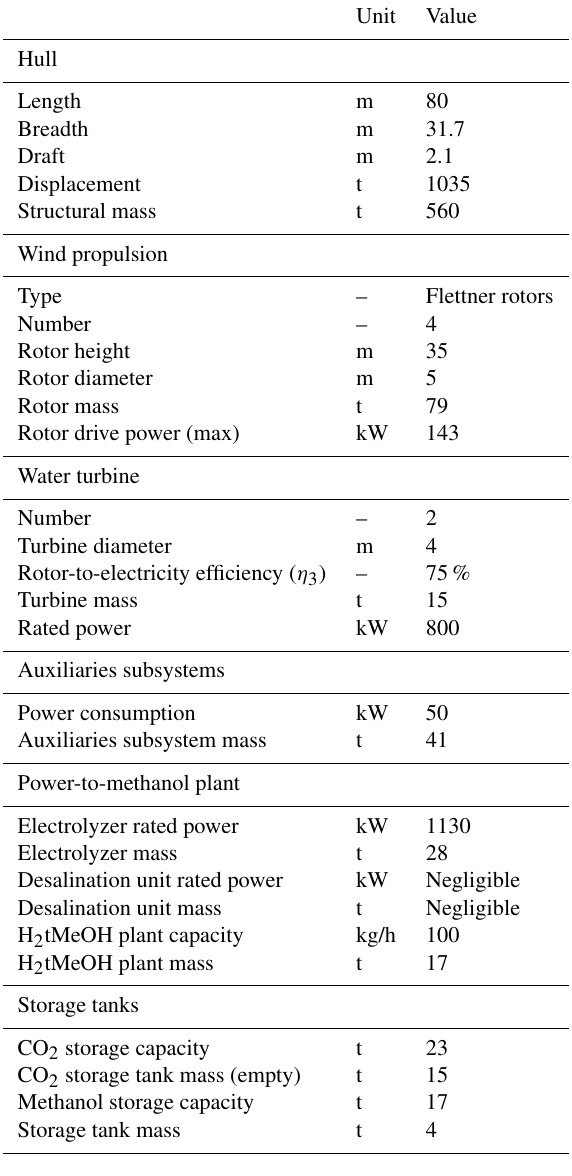
Table 1. Specifications of the updated energy ship